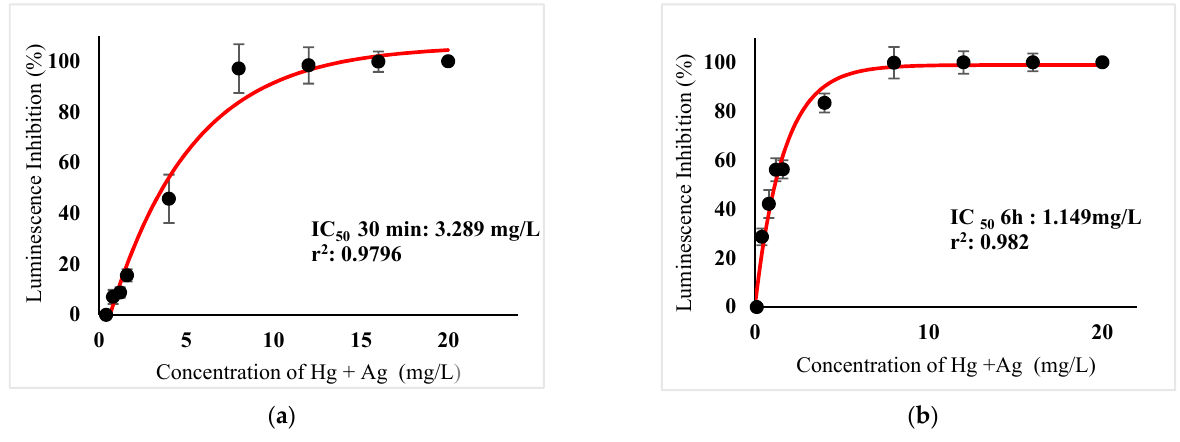
Figure 8. ( a ) Acute and ( b ) Chronic toxicity of mixture Hg 2+ + Ag + in concentration ratio of 1:1 on luminescence inhibition of Photobacterium sp.NAA-MIE. Data represent mean ± SD, n = 3.